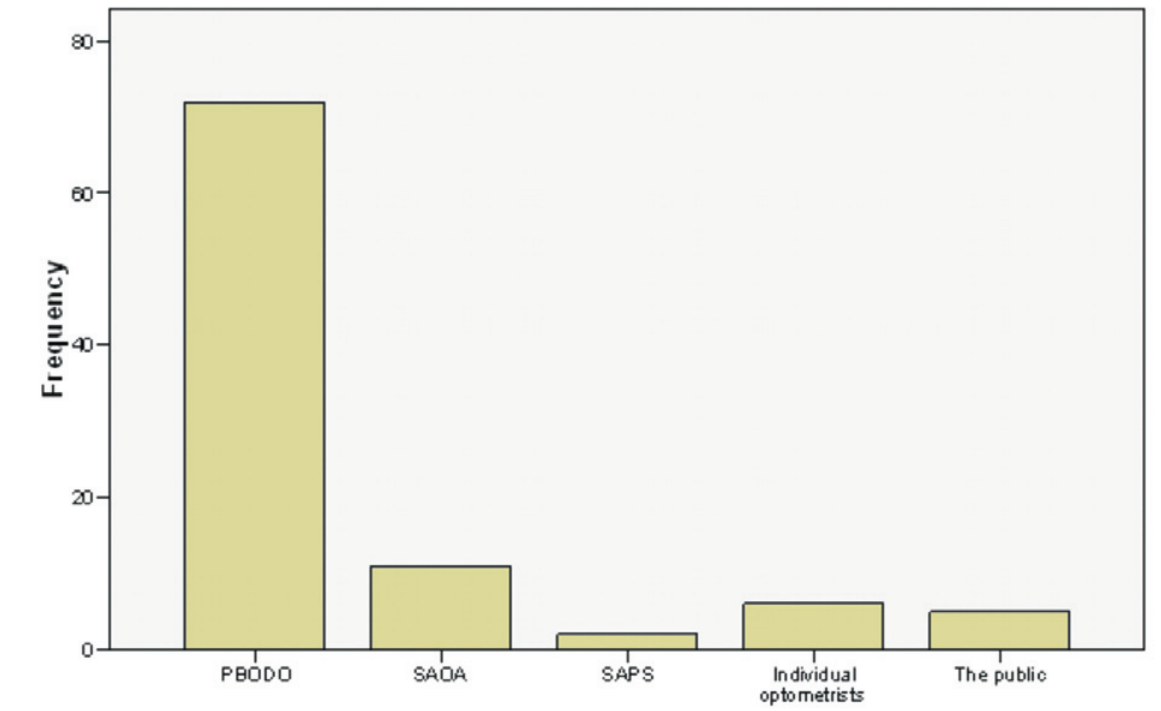
In terms of who should be responsibility for policing the sale of readers, the majority (74%) of practitioners felt that the PBODO should be responsible (Figure 3).